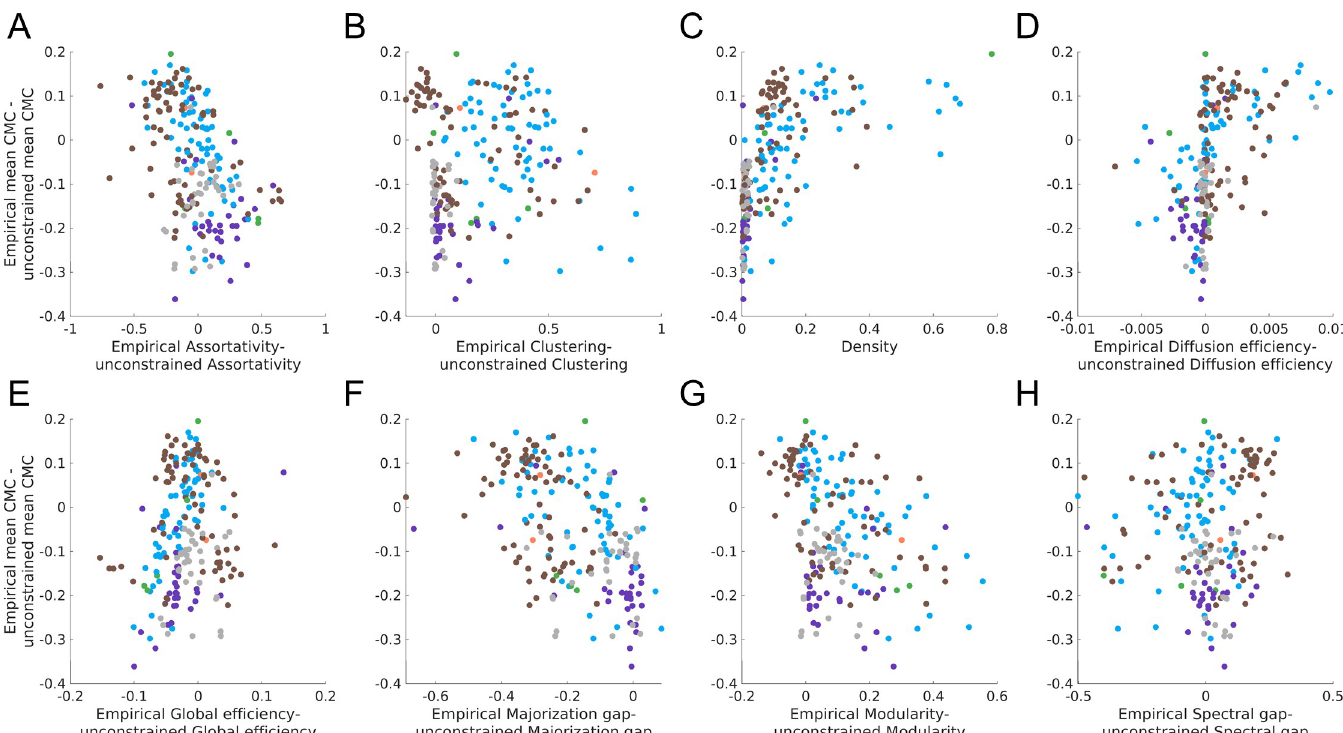
Fig 5. Difference between unweighted empirical and unconstrained surrogates in mean within-network CMC and network properties. The y-axis of each plot shows the difference between the empirical networks and unconstrained surrogates mean within-network CMC. The x-axis shows the difference between the empirical networks and unconstrained surrogates on a particular property (except for panel C as the unconstrained surrogates have the same density as the empirical network). On both axis, except for the x-axis in panel C , a negative value indicates the empirical network had a lower value than the mean value of the surrogates, while a positive value indicates the empirical networks had a larger value. Points are coloured by the natural category of the empirical network (blue = social, grey = technological, brown = biological, orange = informational, purple = transportation; green = economic).